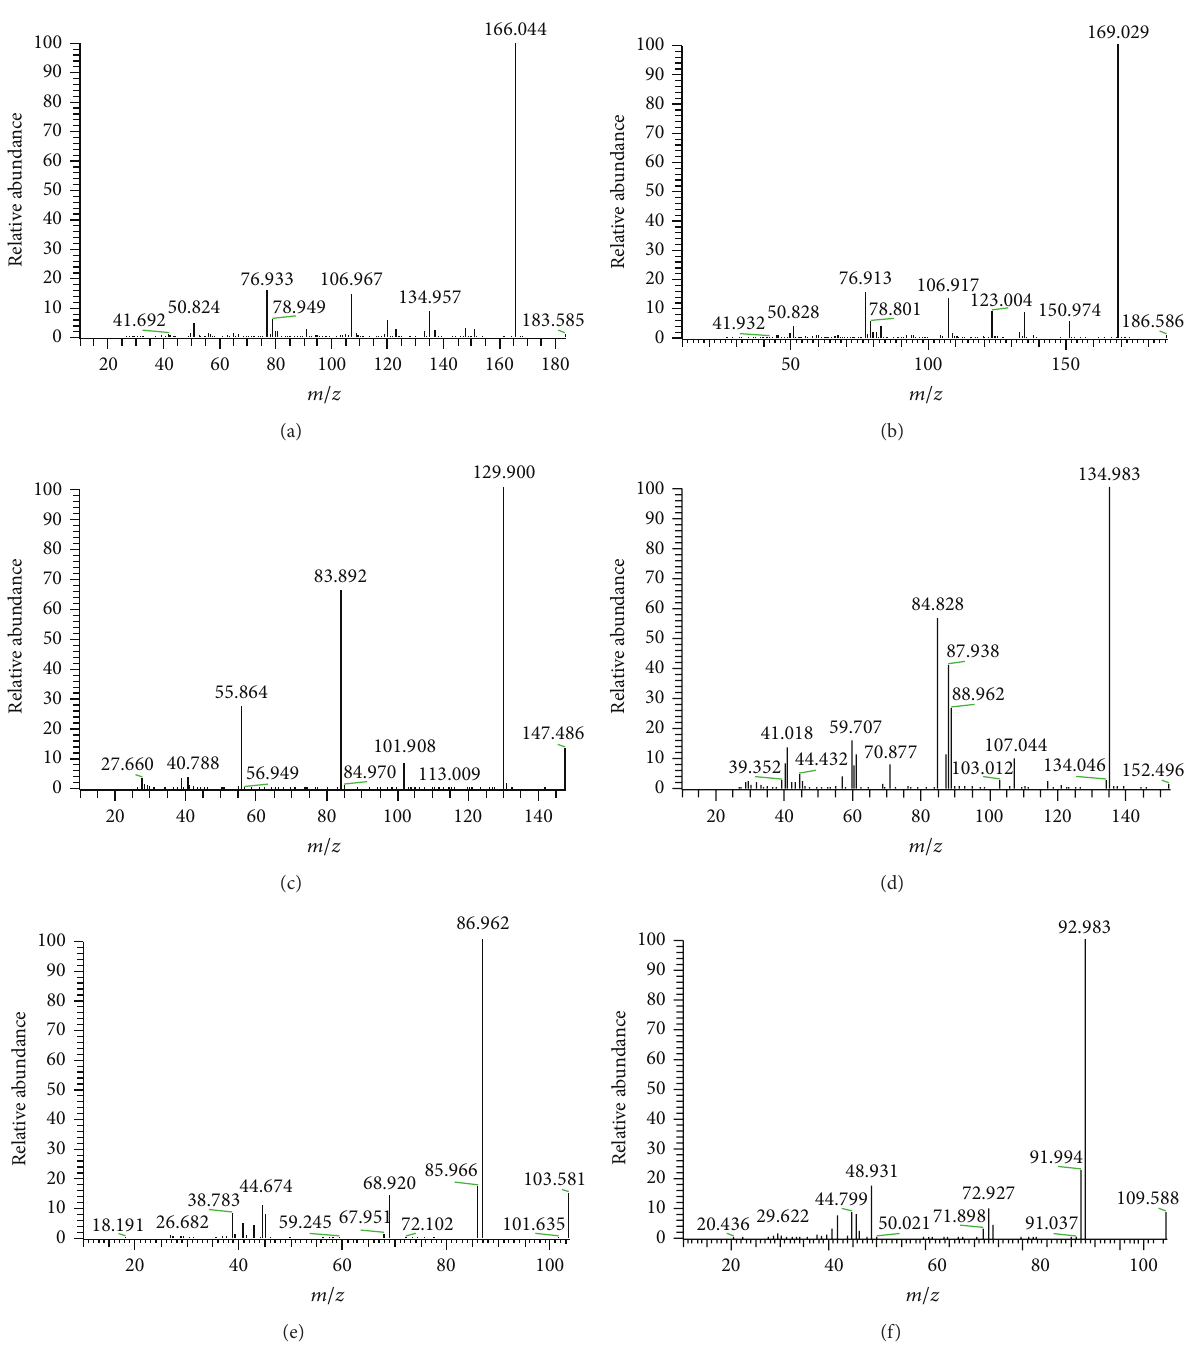
Figure 3: Product ion spectra for (a) epinephrine, (b) epinephrine-D 3 , (c) glutamate, (d) glutamate-D 5 , (e) 𝛾 -aminobutyric acid, and (f) 𝛾 -aminobutyric acid-D 6